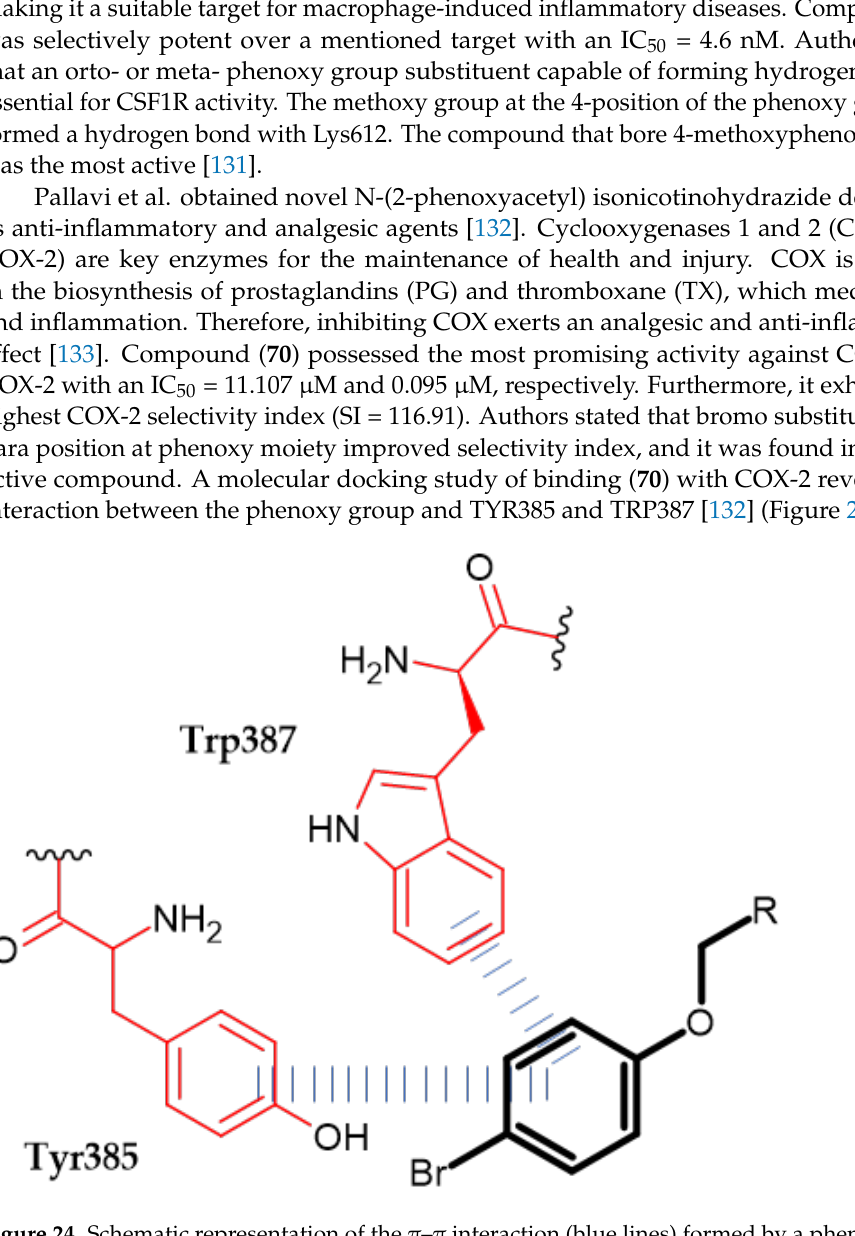
Figure 24. Schematic representation of the π – π interaction (blue lines) formed by a phenoxy group (R is the rest of the compound structure).